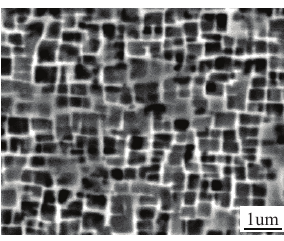
Figure 2. Morphology of the alloy 2 after fully heat treated.